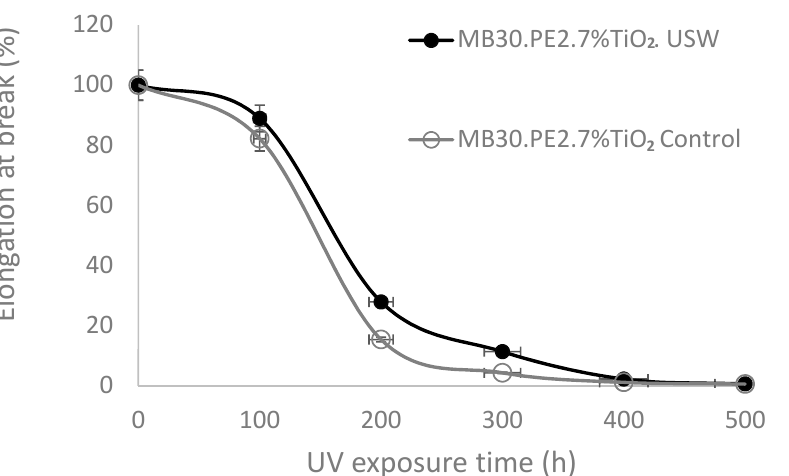
Figure 5. E ff ect of USME-VF process on TiO 2 prodegradant e ff ect by indirect measure of elongation at Figure 5. Effect of USME-VF process on TiO 2 prodegradant effect by indirect measure of elongation break in white films with TiO 2 at 7 wt%. at break in white films with TiO 2 at 7 wt%.